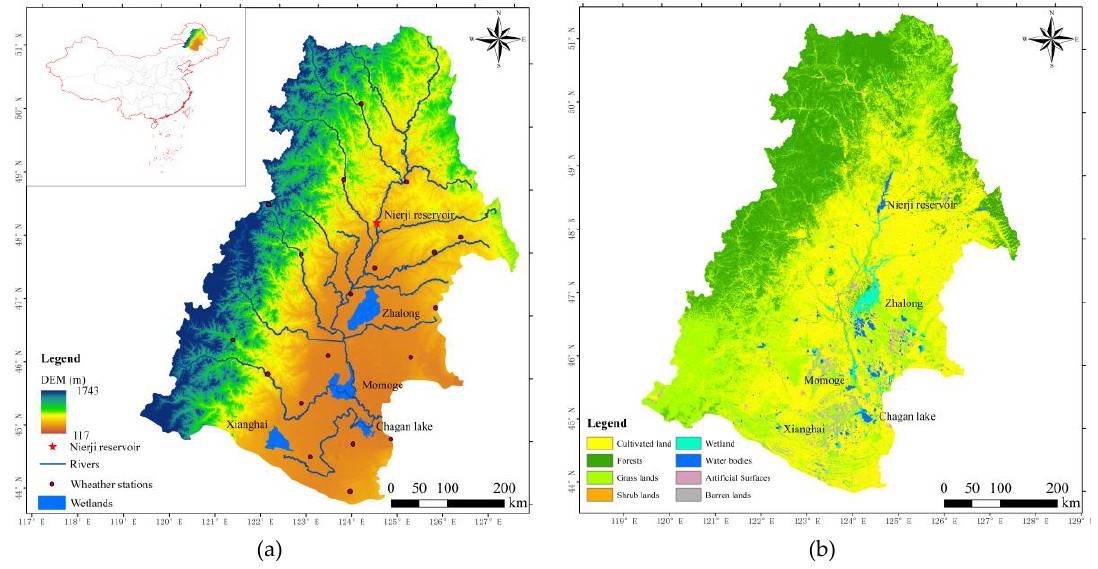
Figure 1. ( a ) Geographical location and ( b ) land use of the Nenjiang River Basin, Northeast China, with four large open water bodies, including the Zhalong wetland, Xianghai wetland, Momoge wetland, and Chagan Lake.